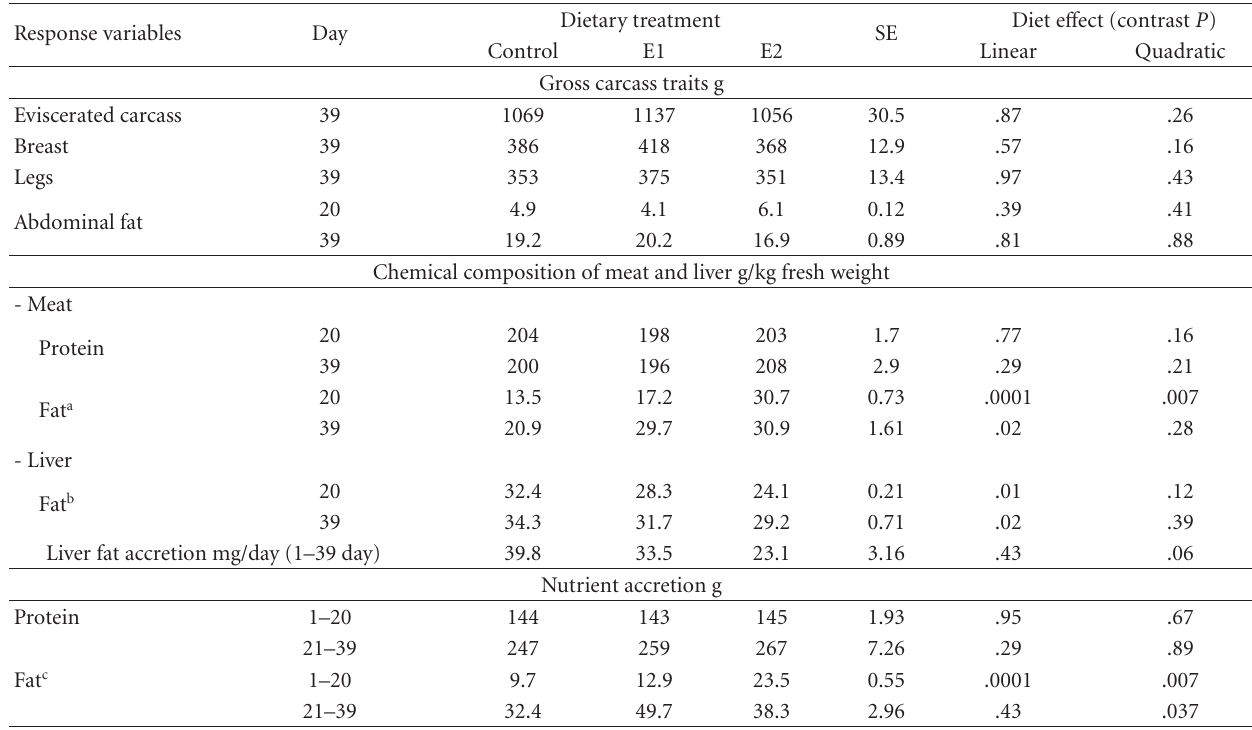
Table 4: Gross carcass traits and chemical composition of meat and nutrient accretion in broilers supplemented with exogenous emulsifier in graded doses (means of 3 birds/replicate on day 20 and 4 birds/replicate on day 39). Response